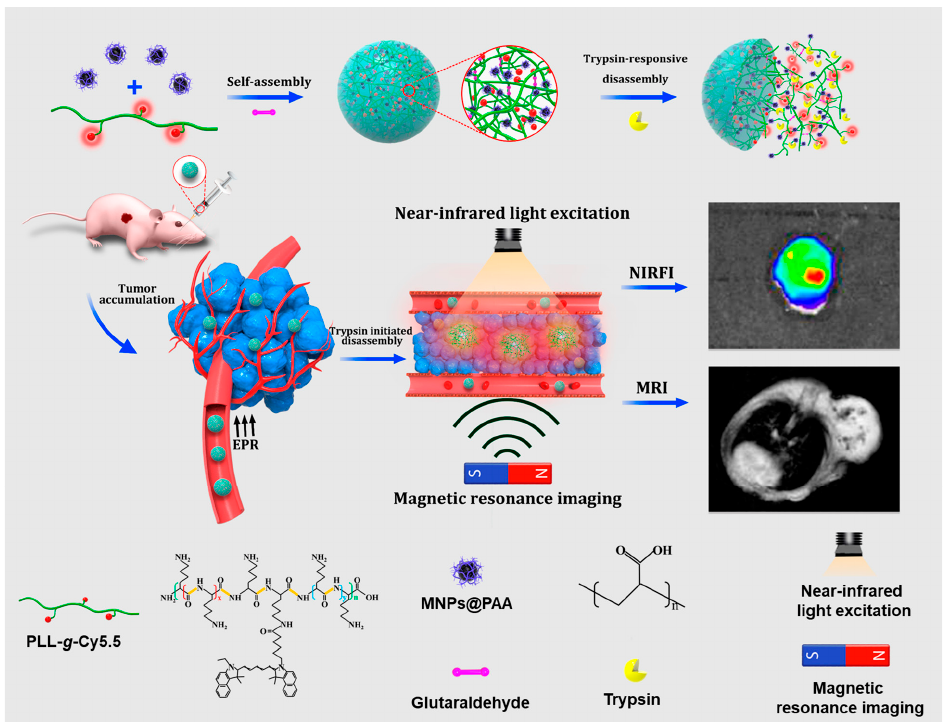
Figure 12. MR imaging and trypsin-responsive substrate/NIRF agents composed of Fe 3 O 4 magnetic nanoparticles whose surface is decorated with polyacrylic acid and Cy5.5-modified poly- D / L -L (P- D / L -L-g-Cy5.5). Reprinted with permission from Reference [167].